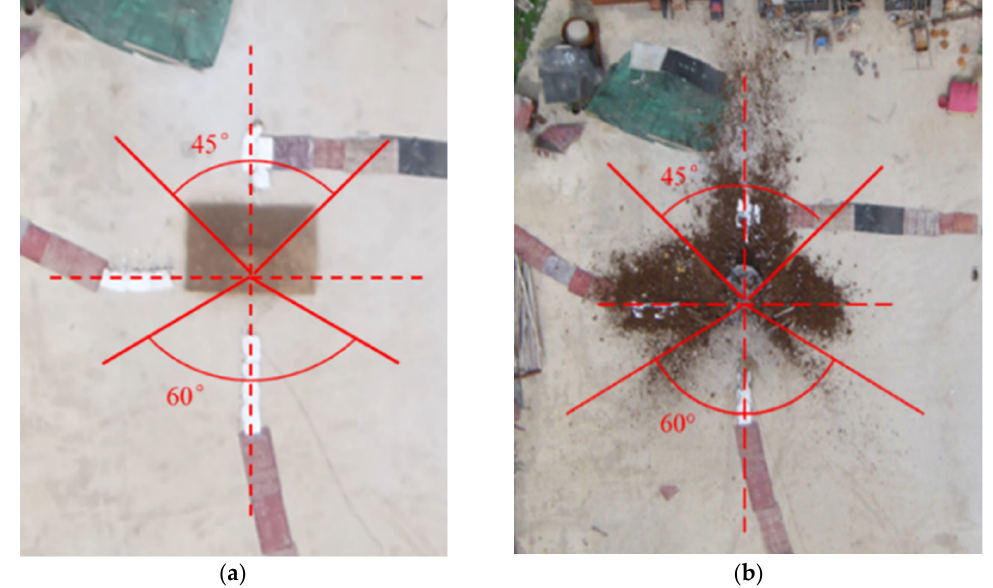
Figure 8. Comparison of models before and after the explosion. ( a ) Before; ( b ) after.